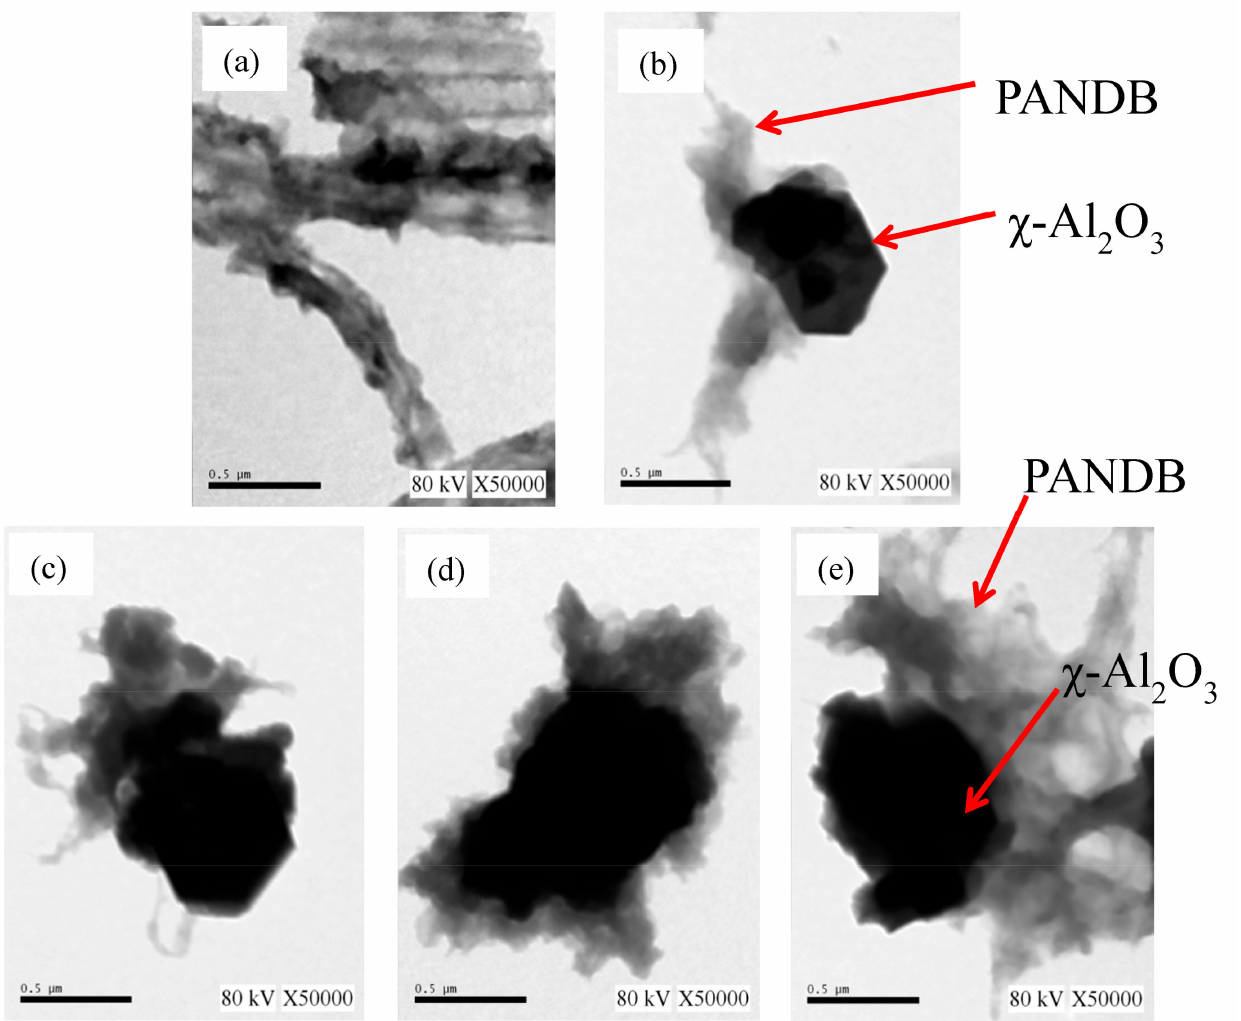
Figure 4. TEM images of ( a ) pure PANDB and conducting PANDB/ χ -Al 2 O 3 core-shell nanocomposites synthesized at AN/ χ -Al 2 O 3 weight ratios of ( b ) 0.5, ( c ) 1, ( d ) 1.5, and ( e )